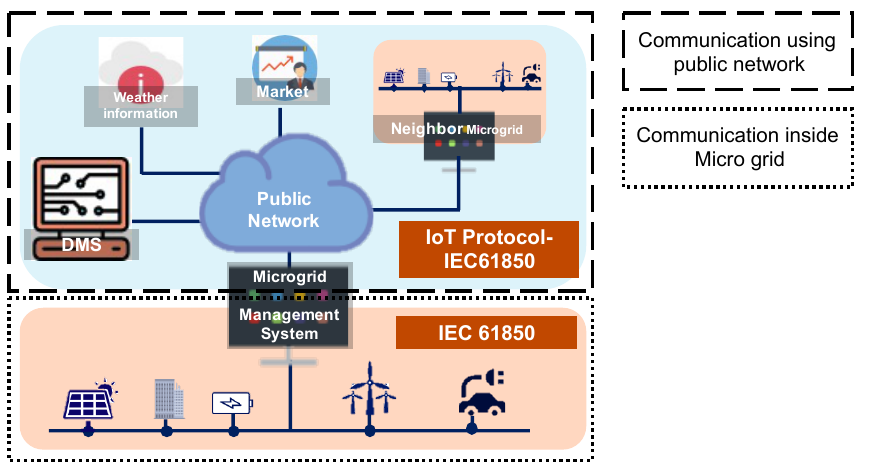
Figure 2. Internal Communications Architecture for the MGMS.